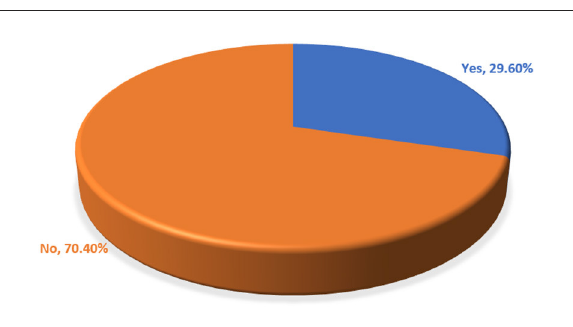
FIGURE2 The overall proportion of the WTP for SHI among public civil servants in DCA, North-East Ethiopia ( n = 796), May